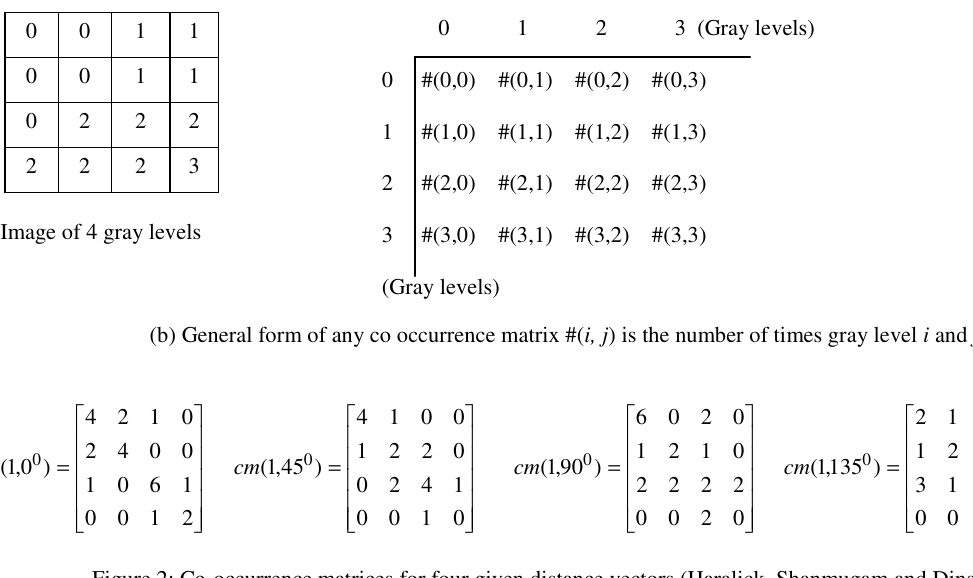
Figur e 2: Co-occurrence matrices for four given distance vectors (Haralick, Shanmugam and Dinstein,